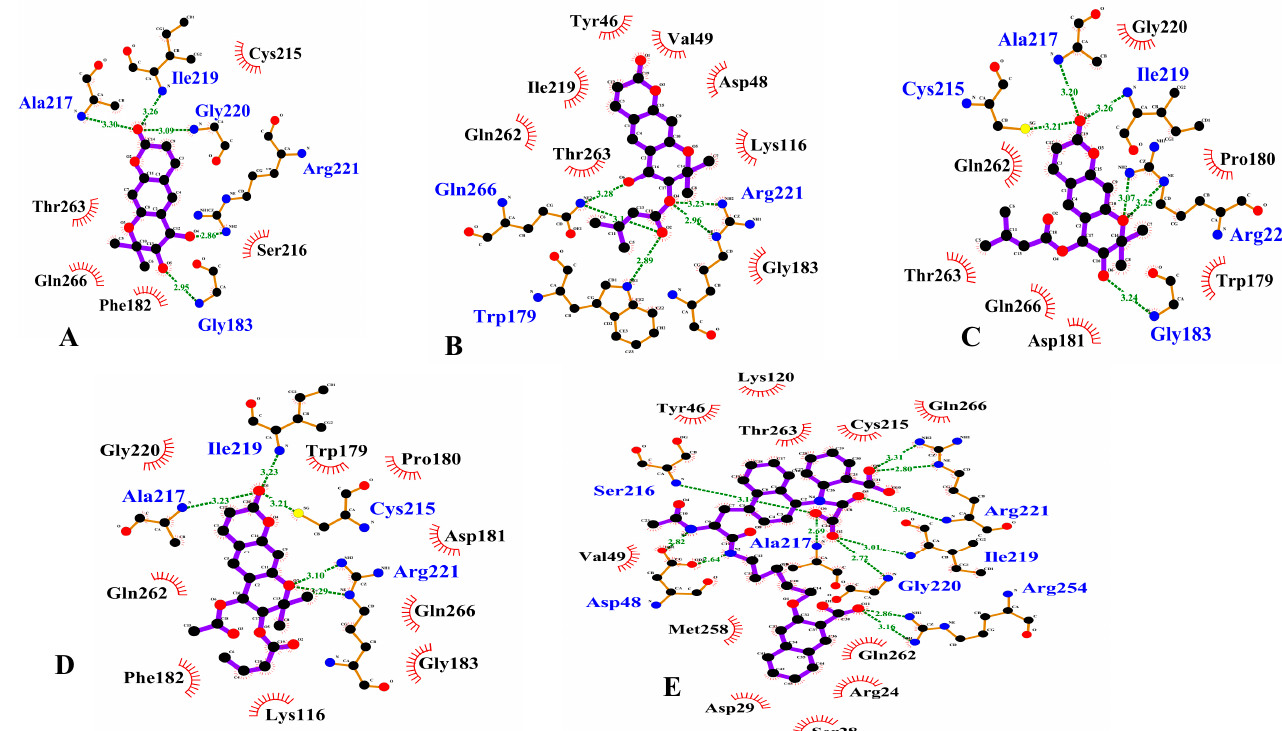
Figure 2. Two dimensional ligand interaction diagram of PTP1B inhibition by (+)- trans -decursidinol ( A ), Pd-C-I ( B ), Pd-C-II ( C ), Pd-C-III ( D ), and compound 23 ( E ). Schematic representation of interaction between ligands (coumarins) and PTP1B, coumarins are presented by thick purple stick models, hydrogen bonds are green dotted lines, and hydrophobic interactions with the corresponding amino acid residues of the enzyme are shown by dashed